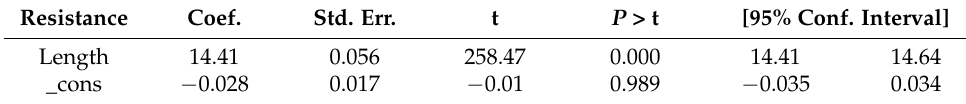
Table 2. Regression analysis of length vs. resistance of SS conductive yarn. Resistance Coef.